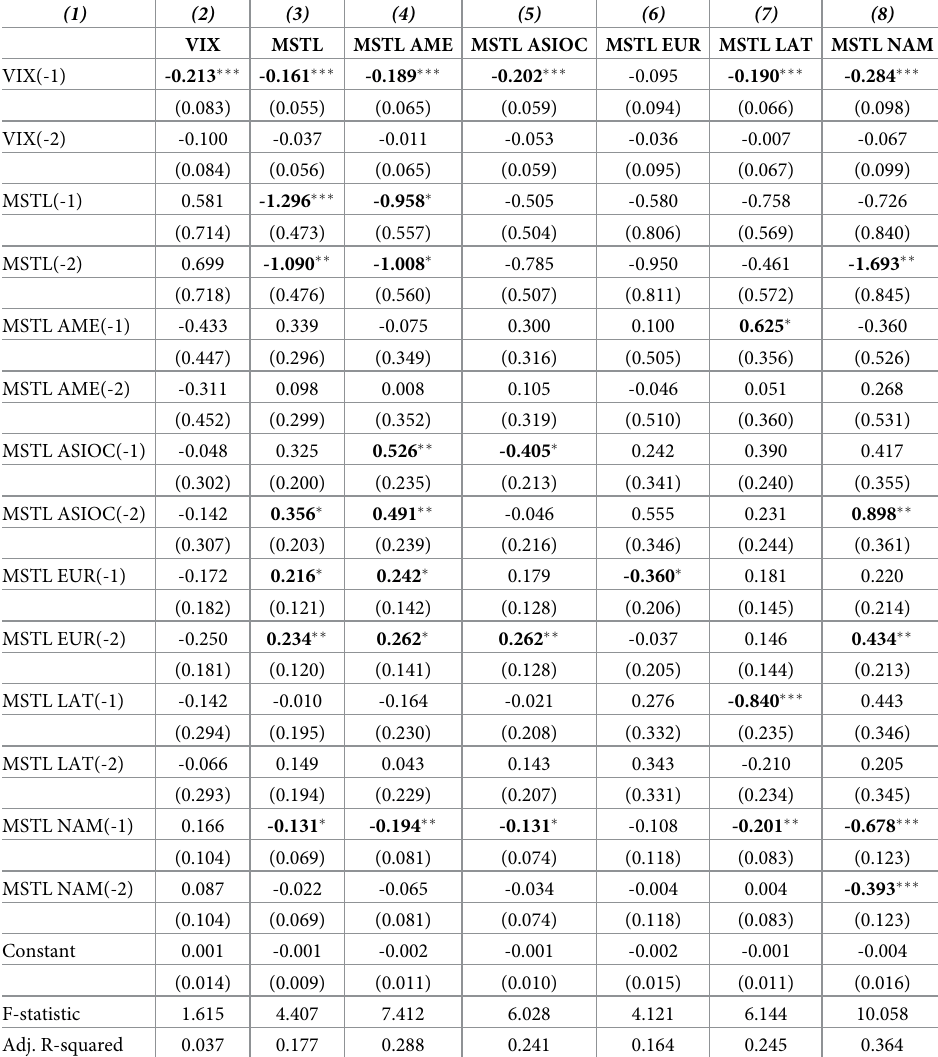
Table 8. VAR Results for VIX and MSTLs